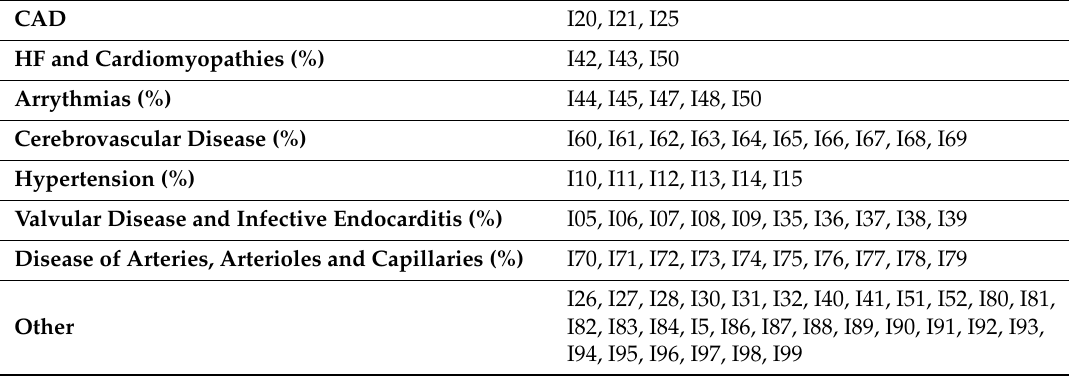
Table 1. ICD codes for individual cardiovascular